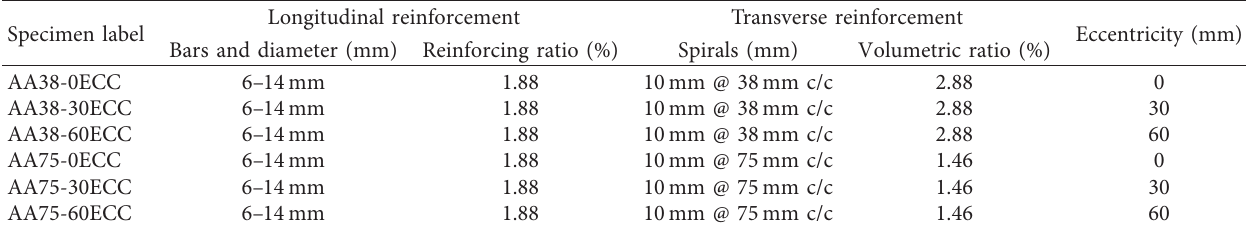
Table 3: Test matrix.